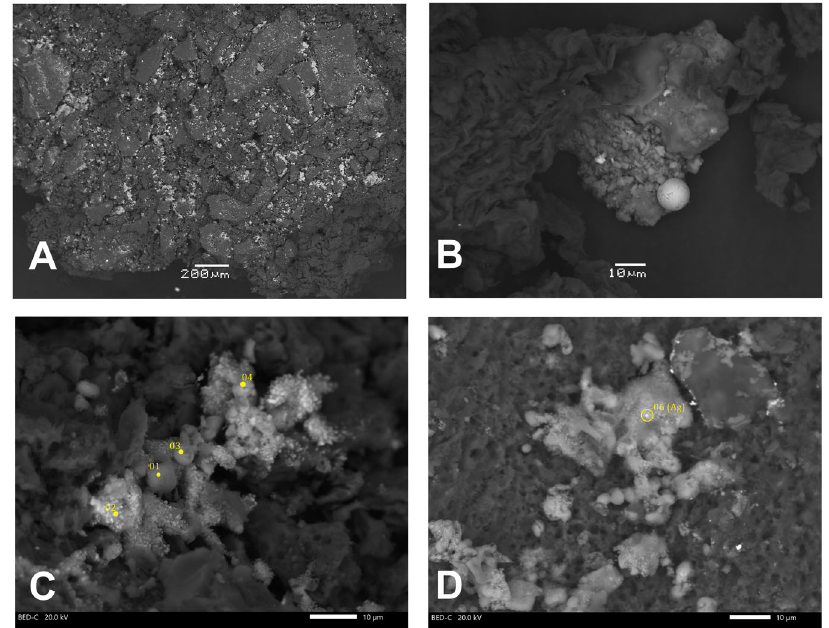
Fig. 5 Scanning electron microscopy of the graphite sample after leaching, BSE mode. A General view. B Quasispherical natural zeolite particle. C , D Typical aluminosilicate precipitates. D A precipitate with Ag admixture. Scale bars: 200 µm in ( A ); 10 µm in ( B – D